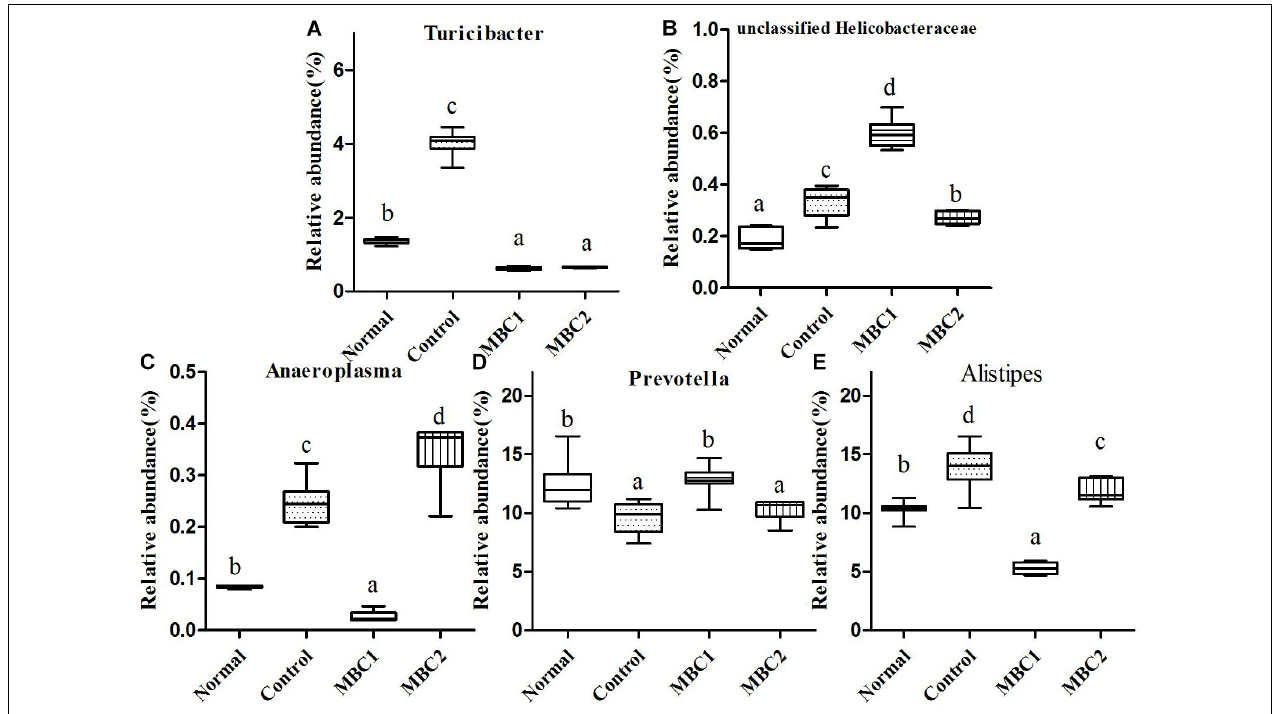
FIGURE 5 | Relative abundance (%) of fecal microbial taxa at the genus level in constipated mice fed CMB. (A) Turicibacter , (B) unclassified Helicobacteraceae, (C) Anaeroplasma , (D) Prevotella and (E) Alistipes .